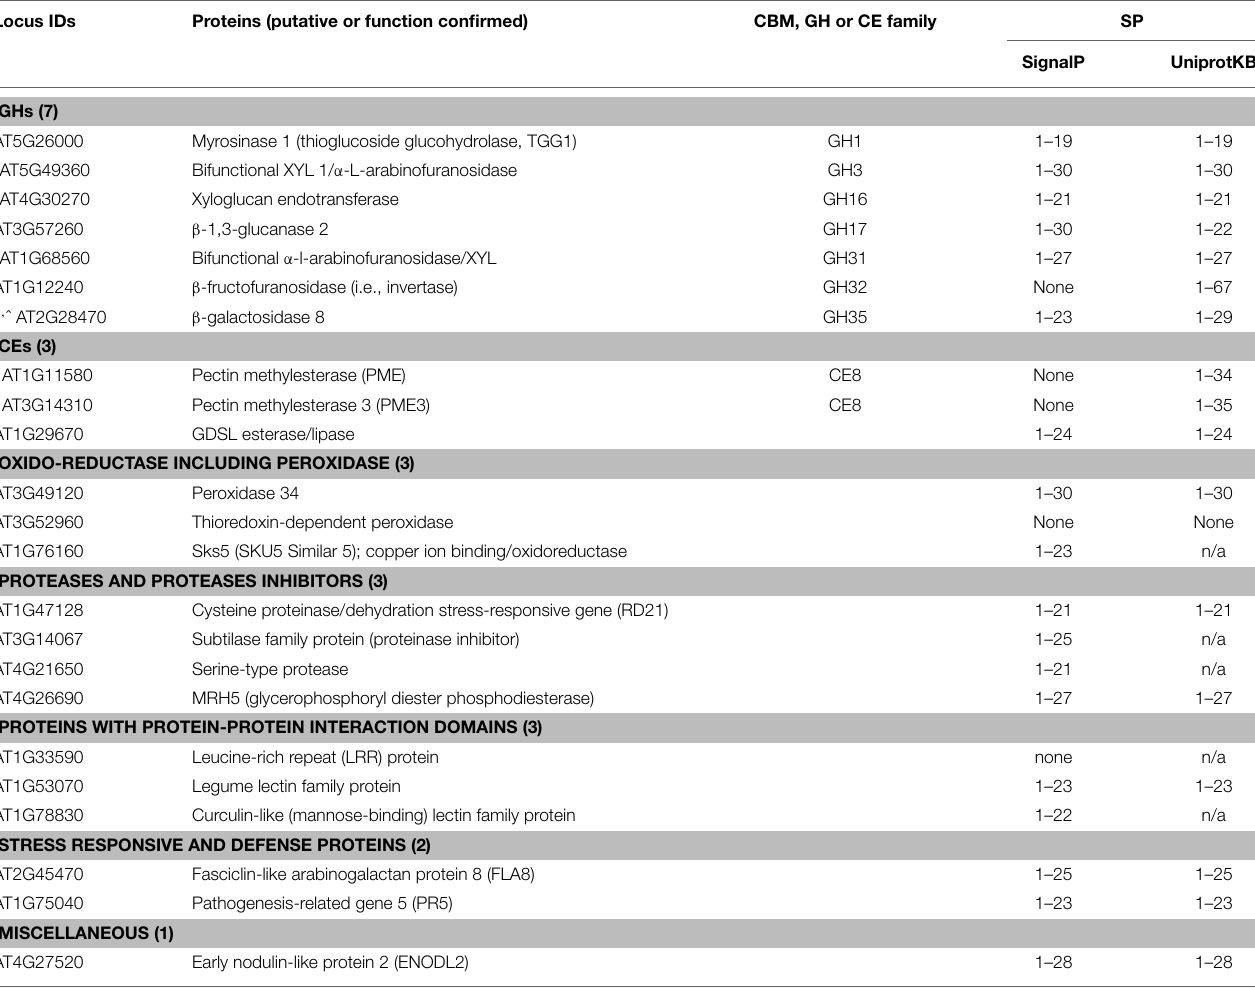
TABLE 2 | List of 22 identified ionically bound cell wall proteins by the in-gel method coupled with LC-MS/MS in stems of Arabidopsis at the late growth stage. Locus IDs Proteins (putative or function